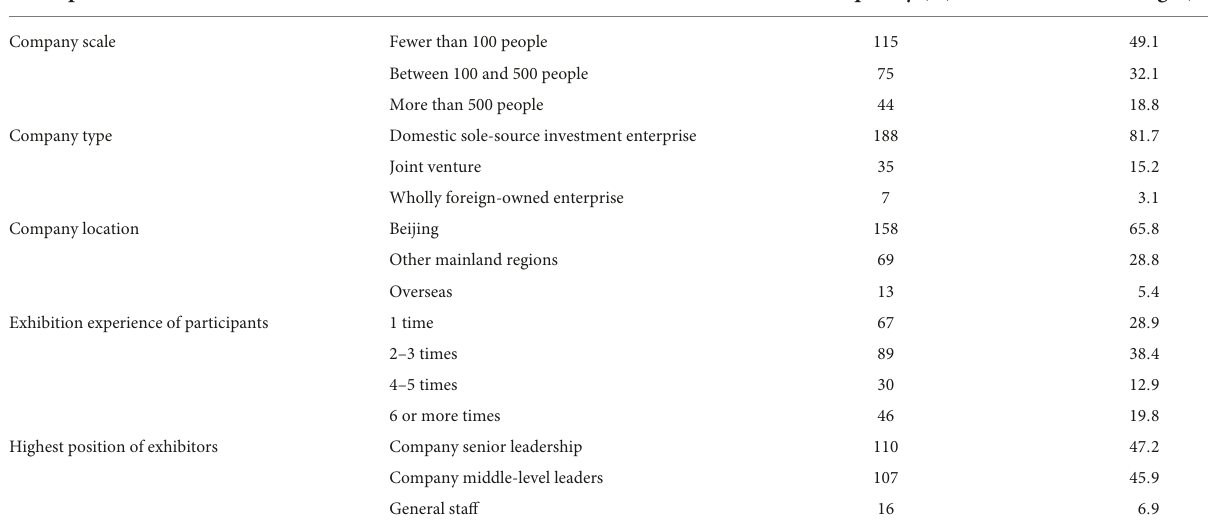
TABLE 6 Comparison table of fitting indexes.